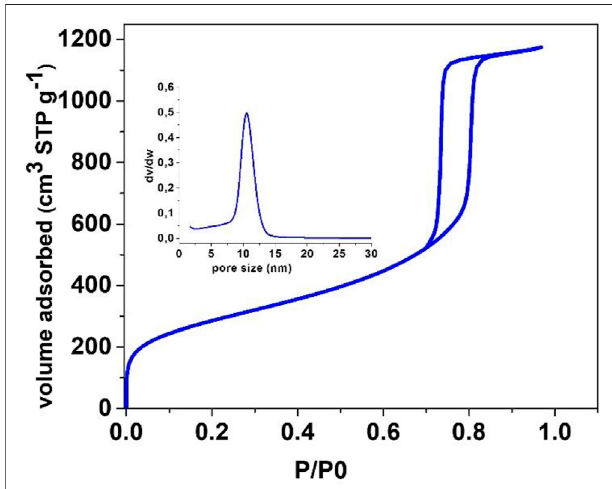
FIGURE 7 | N 2 physisorption isotherm of calcined zeotile-4 made using Pluronic P104, similar class of material discussed in Pulinthanathu Sree et al. (2012) and Pulinthanathu Sree et al. (2017). The pore size distribution PSD is shown in the inset.